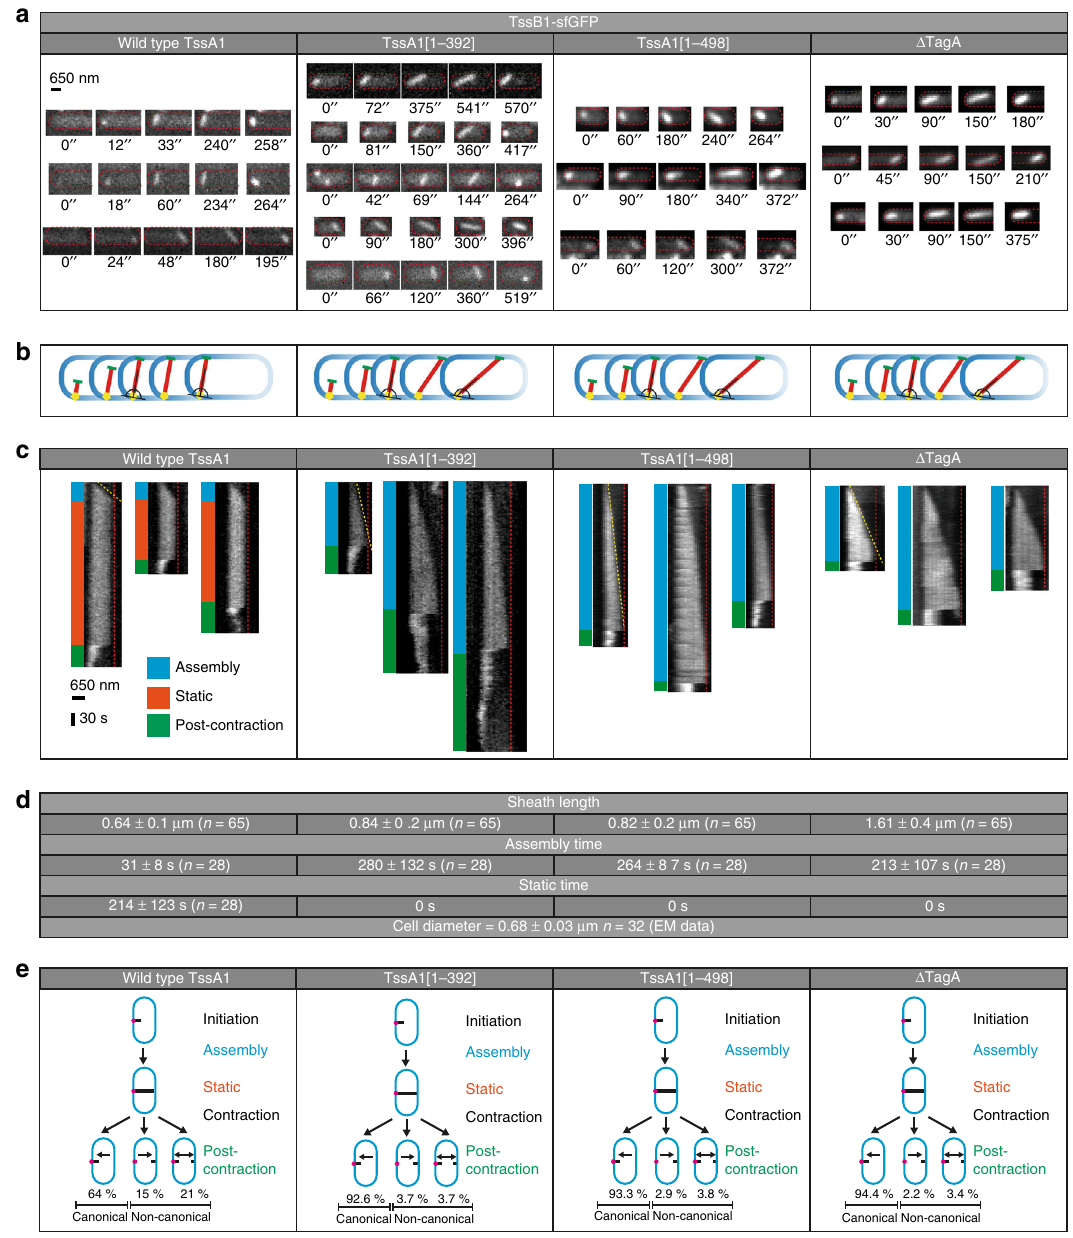
Fig. 5 TssA1 mediates tail elongation termination, anchoring the T6SS distal end to the cell envelope, and non-canonical contraction toward the distal end. a Shown is a comparison of EAEC TssB1-sfGFP time lapse imaging (time points indicated) in wild type TssA1, TssA1[1 – 392], TssA1[1 – 498], and Δ TagA backgrounds, respectively. In the TssA1[1 – 392], TssA1[1 – 498], and Δ TagA backgrounds, polymerizing structures that reached the opposite membrane continued to elongate, resulting in sliding of the T6SS distal end against the IM (to accommodate for increasing length) until contraction occurred (last image in each sequence). See Supplementary Movie 6. In contrast, when Δ tssA1 was complemented with wild type tssA1 , elongation terminated once the distal end approached the inner membrane and the sliding phenotype was not observed (see also Fig. 1 and Supplementary Movie 2). The proximal end remained static, except when it snapped off the cell envelope resulting in the tail-sheath module fl oating in the cytoplasm. The distal end in the wild type background became static once the T6SS spanned the entire cell width, whereas the distal end in all the presented mutants was sliding along the IM, leading to a change in the angle of the T6SS with respect to the cell envelope. b The shown schematic recapitulates sheath dynamics before contraction that were observed in ( a ). Proximal end, yellow; distal end, green; T6SS sheath, red. c , d Further analyses of sheath dynamics (kymographs shown in c revealed that in the presented mutant backgrounds, structures kept polymerizing (slower than for wild type-TssA1, yellow line slope) until contraction occurred and never entered a static extended phase. Sheaths were on average longer than the cell diameter. In contrast, for wild type TssA1, T6SSs entered a static extended phase upon spanning the entire cell width and the average sheath length was comparable to the average cell diameter. Source data are provided as a Source Data fi le. e The complementation of Δ tssA with tssA1 [1 – 392] ( n = 547) or tssA1 [1 – 498] ( n = 209) on a plasmid showed a signi fi cantly reduced number of non-canonical contractions, as compared to complementation with wild type tssA1 on a plasmid ( n = 143) and wild type tssA1 in the native locus (Fig. 1d). TssA1 therefore mediates non-canonical contractions. Δ tagA ( n = 90) background also reduced the number of